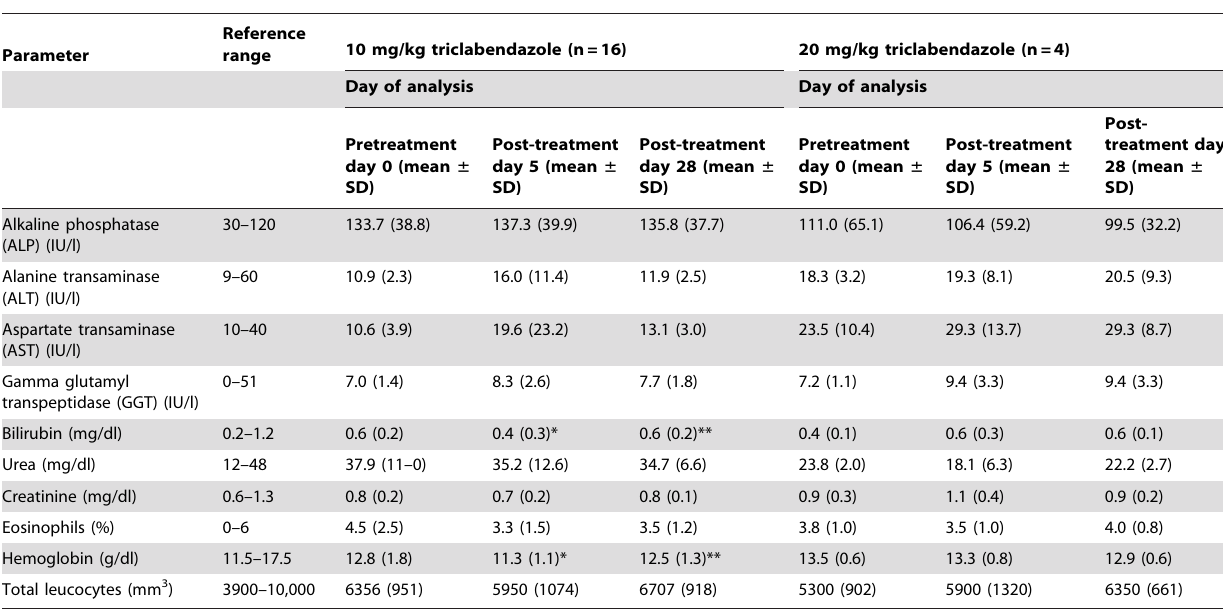
Table 4. Liver and renal function and hematological parameters pre- and posttreatment with triclabendazole.